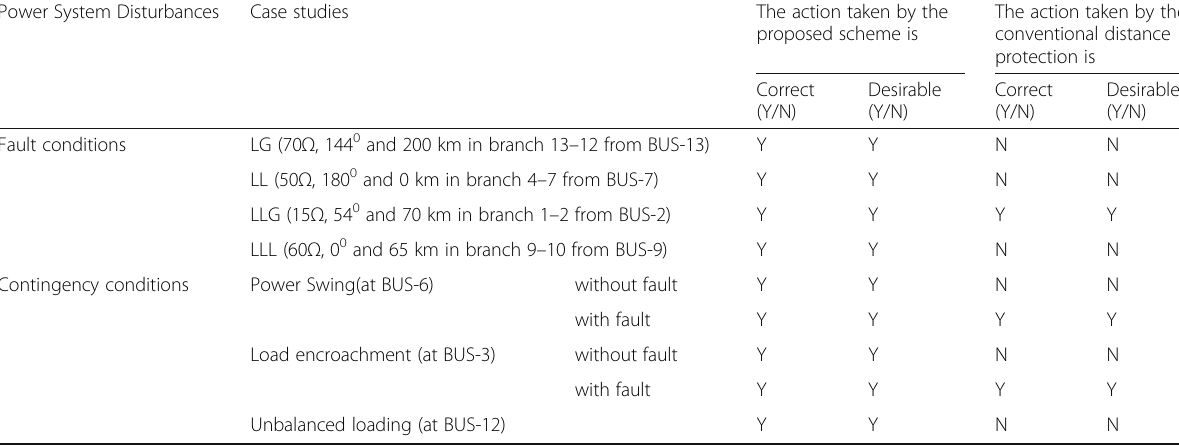
Table 5 Comparative analysis of the proposed methodology with conventional distance relay during various power system disturbances in IEEE-14 bus